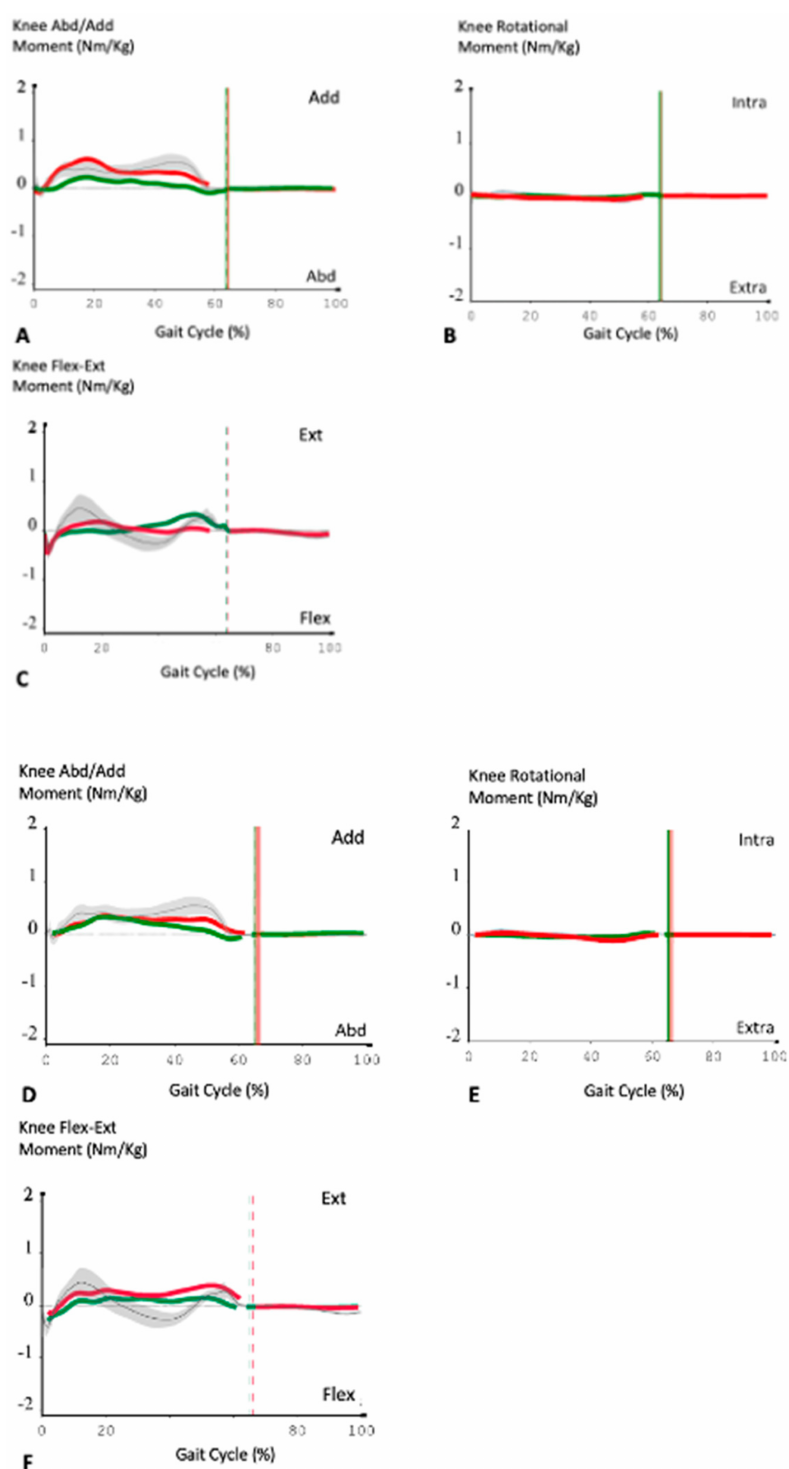
Figure 5. Descriptive kinematic analysis of two patients: one from Group A ( A – C ) and one from Group B ( D – F ). In both series, the operated knee is the right one (green lines) and normal values are represented by grey lines and the grey area (SD). The red lines represent the left, non-operated, knee. The flexion–extension, abduction–adduction and the rotational moments of the prosthetic knee had no major variations during the gait cycle. A reduction of these external forces could be related to the surgical technique used (mechanical alignment) and the type of prosthesis employed (PS one). It would ensure less stress and therefore greater longevity to the